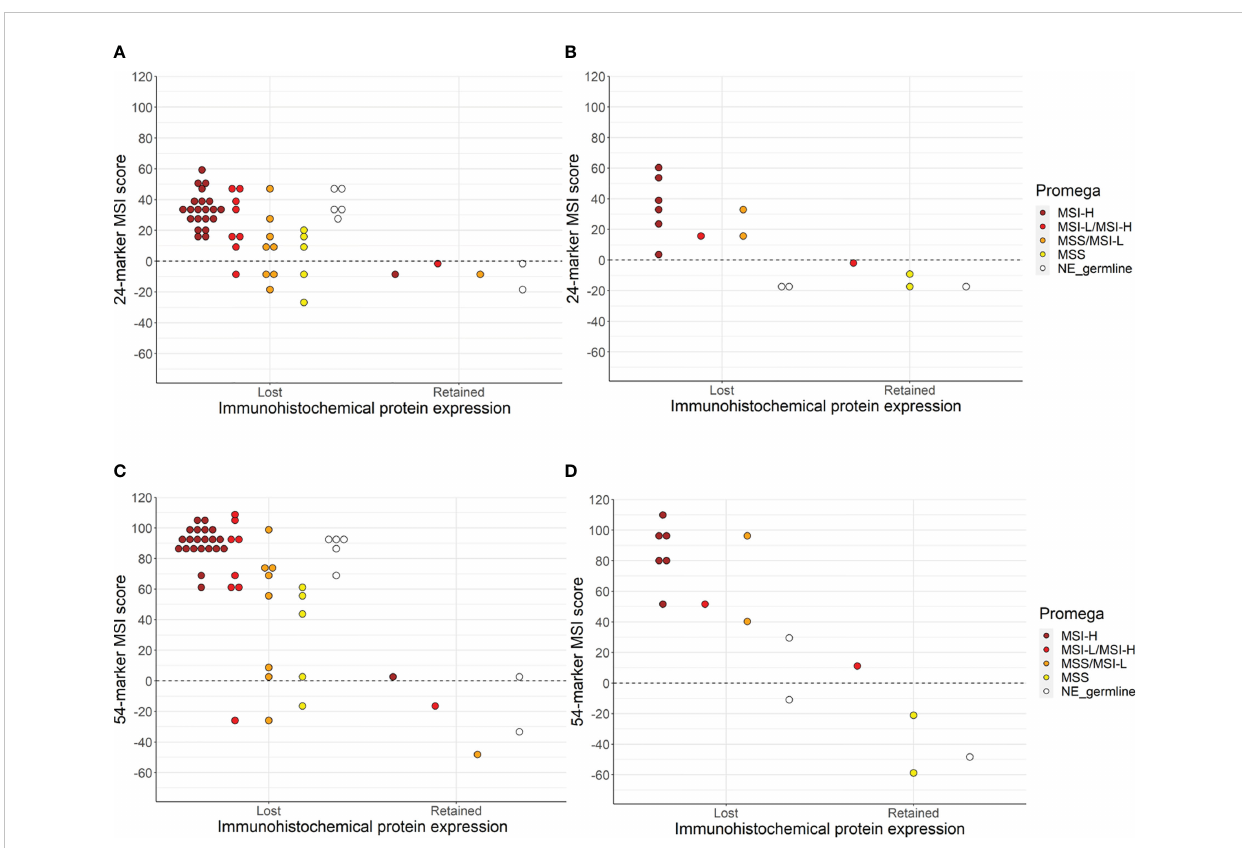
FIGURE 1 The concordance between immunohistochemical protein expression, Promega MSI assay, and sequenced-based MSI assay using the 24-marker assay for carriers (A) , and FDRs (B) or the 54-marker assay for carriers (C) and FDRs (D) . NE_germline are the samples that were non-evaluable (NE) due to the lack of germline